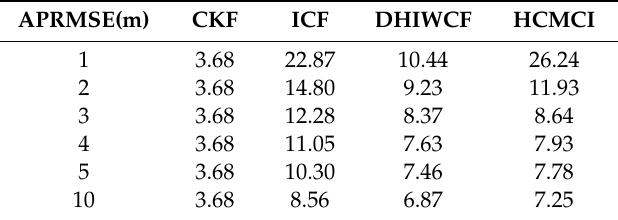
Table 1. Comparison of ARMSE for di ff erent algorithms.